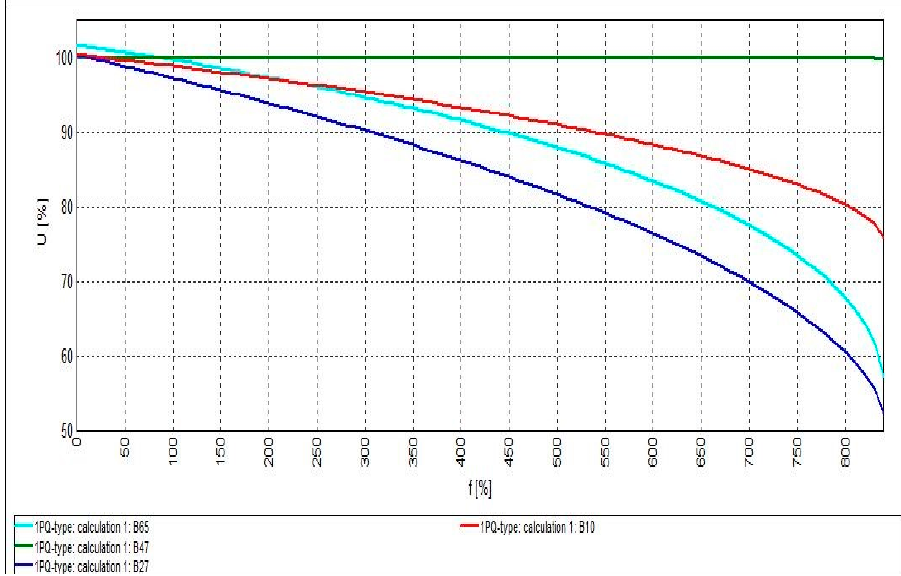
Figure 10. PV curves of the IEEE 69 ‐ node RDS system with 1 PQ ‐ type DG installation.